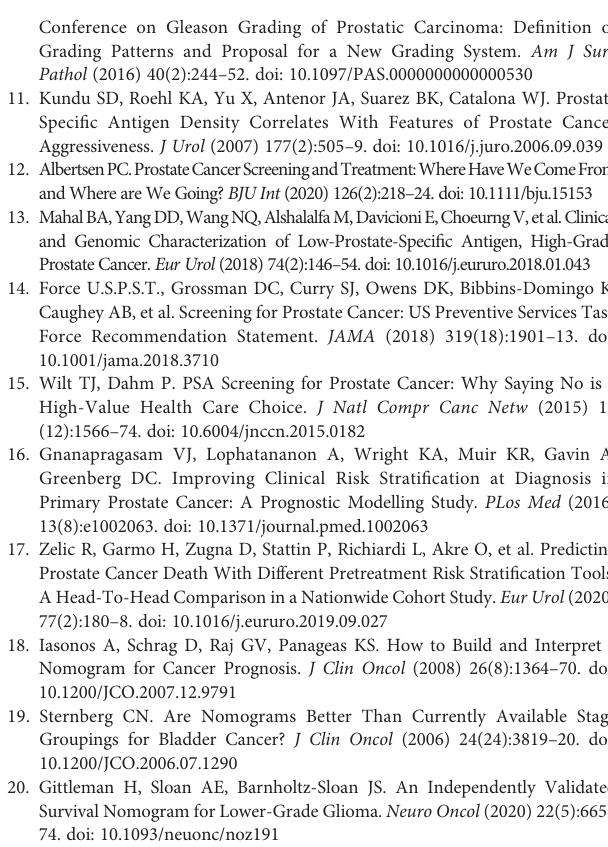
Supplementary Figure 1 | The AUC at 1-,2-year in the external validation set in time. A: The AUC at 1-,2-year in the external validation set for CSS was 89.2 and 90.3. B: The AUC in the external validation set for OS was 78.3 and 89.8. Supplementary Figure 2 | The AUC at 3-,5-,8-year for predicting CSS and OS after deleting the unknown GS. A: The AUC at 3-,5-,8-year for predicting CSS after deleting the unknown GS was 76.4,82.6, and 82.3.B: The AUC at 3-,5-,8-year for predicting OS after deleting the unknown GS was 65.9,77.9 and